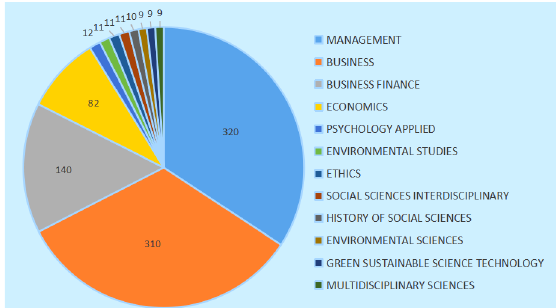
Figure 6. The top 12 subject categories